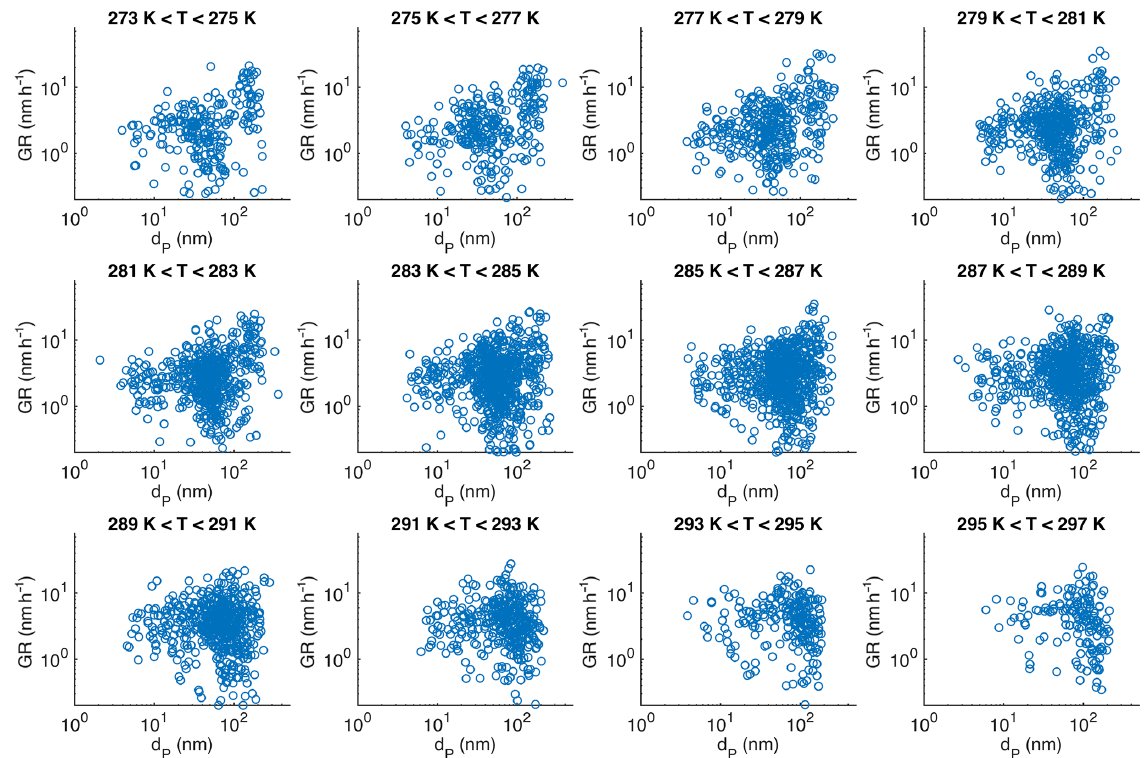
Figure 9. Growth rate as a function of particle diameter for growth periods with duration >2 in April–September, presented in temperature